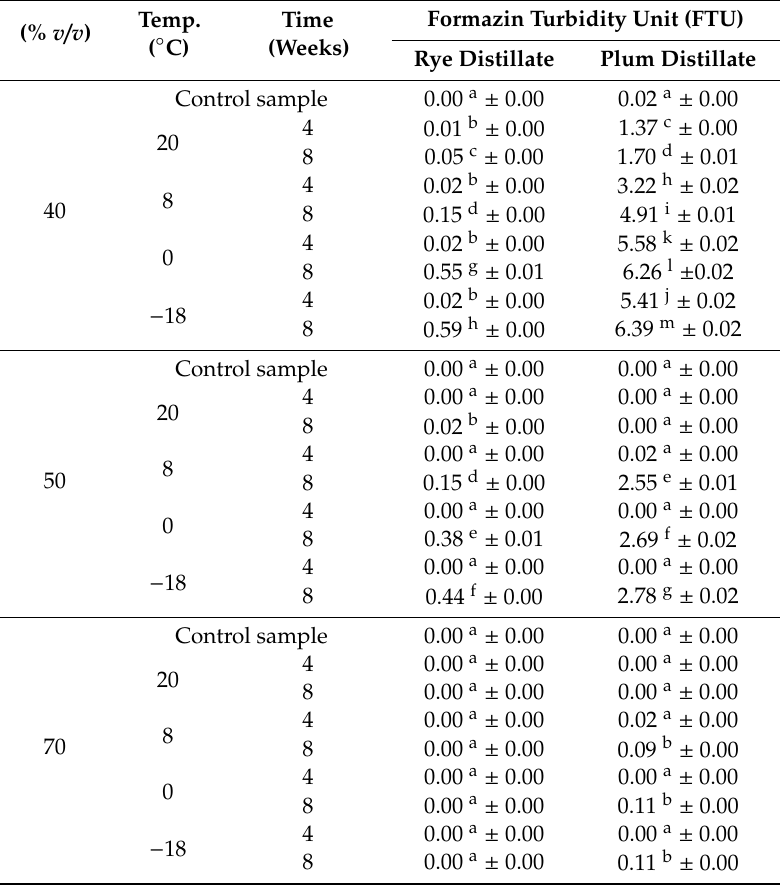
Table 1. Turbidity changes during storage of samples of rye and plum distillates with di ff erent ABVs. (% v / v )